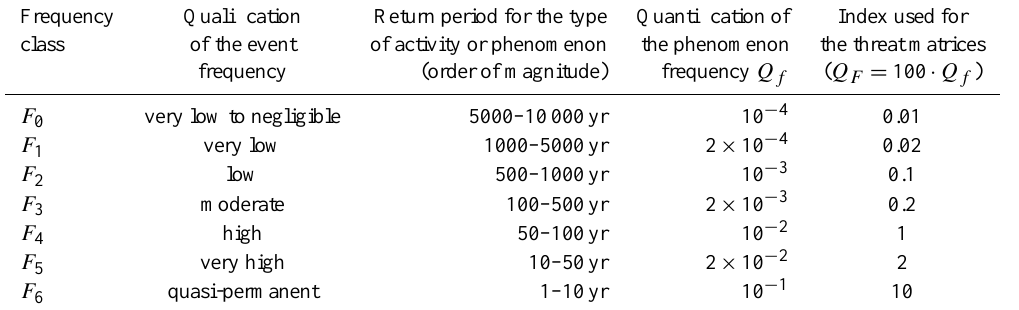
maximum corresponding to loss of life Table 3. Frequency baseline for all adverse events. Frequency Qualification Return period for the